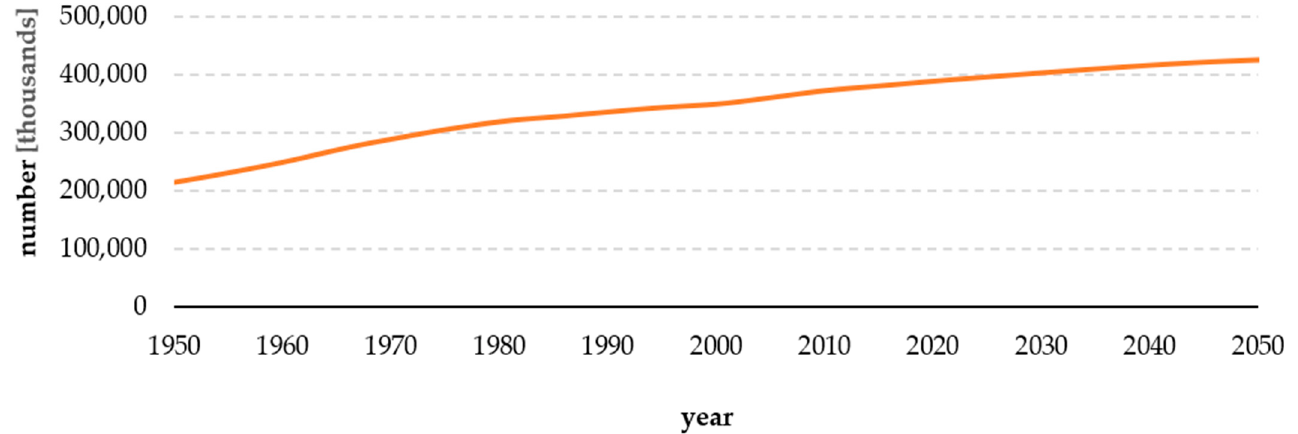
Figure 3. Predicted number of people living in cities in relation to the total population of the Eu- ropean Union (own research on the basis of